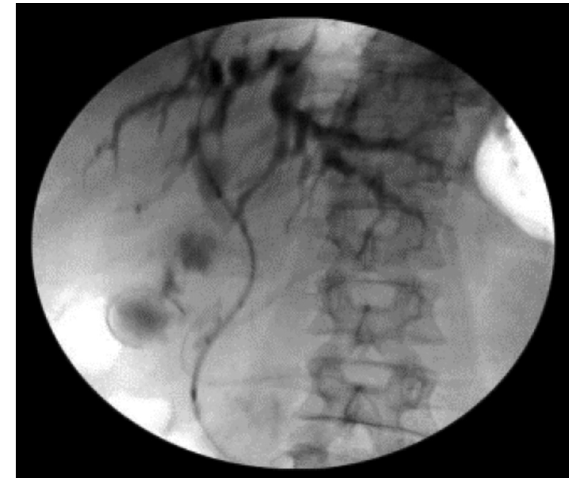
Figure 3. Guide wire placement and anterograde passage through the bile duct